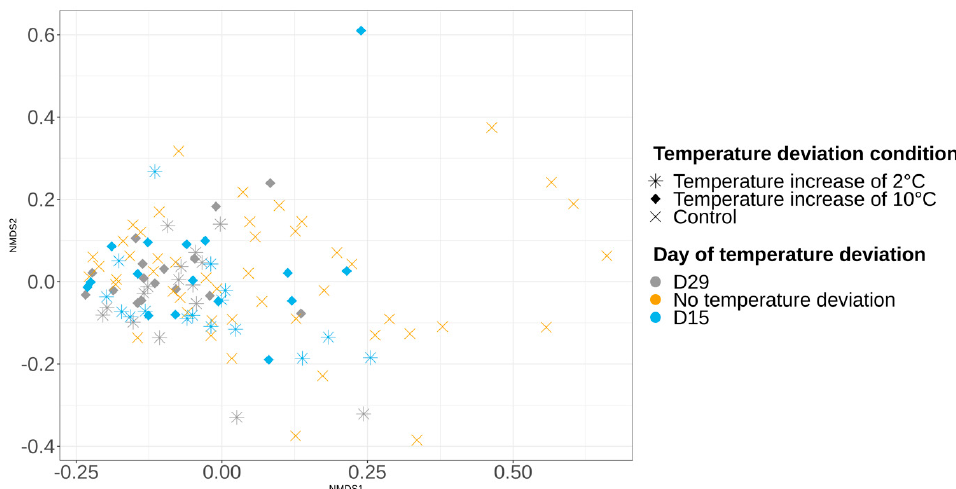
Figure 7. Non-metric multidimensional scaling plot (NMDS) illustrating microbiota beta diversity, calculated with the Bray–Curtis index, comparing control samples to samples that were subjected to a temperature increase of 2 ◦ C or 10 ◦ C, carried out at day 15 and 29, and sampled at day